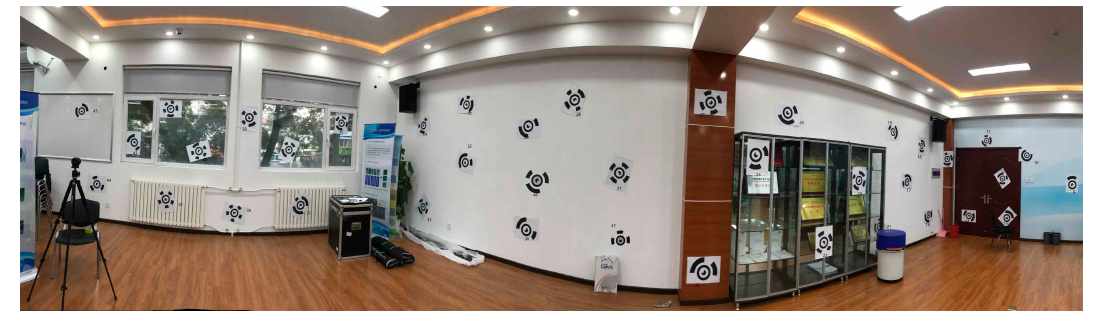
Figure 12. A panoramic photo of the environment of experiment 3.